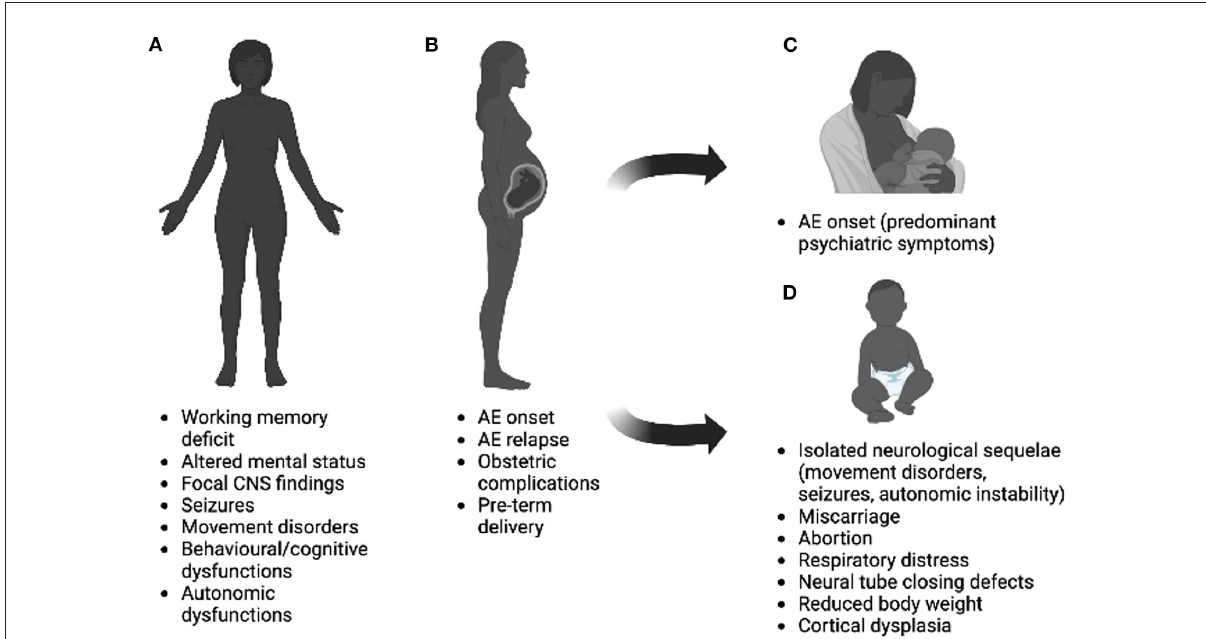
FIGURE1 Interplay between pregnancy and autoimmune encephalitis on women before (A) , during (B) , after (C) pregnancy, and effects on newborns (D) . Possible effects illustrated in the figure refer to rare cases, mostly linked to anti-NMDAR encephalitis and can results from the cumulative effect of antibodies, sedatives, and antiepileptic drugs. Image was created using Biorender.com.